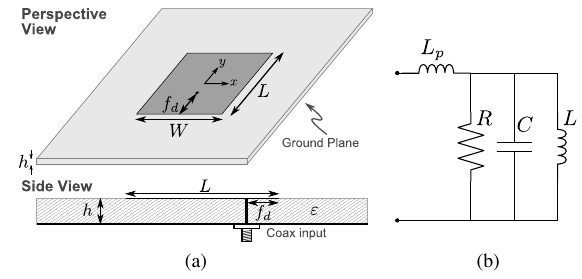
FIGURE 2. (a) Geometry of a simple single-layer, single-feed, probe-fed rectangular patch. (b) Circuit model (which can be generalized to most single-feed, single layer, probe-fed patch